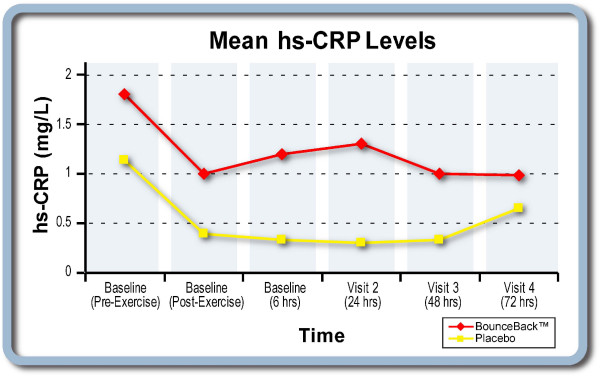
Mean hs-CRP levels.